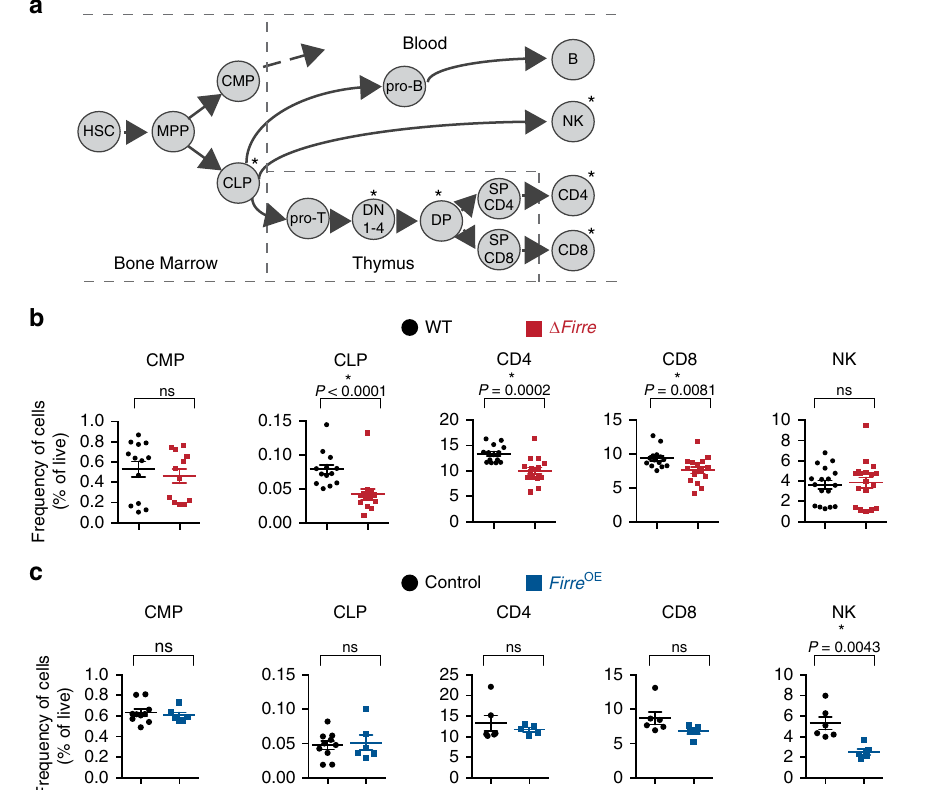
Fig. 3 Δ Firre and Firre OE mice have cell-speci fi c hematopoietic phenotypes. a Schematic of hematopoiesis. b Frequencies of common myeloid progenitors (CMP) and common lymphoid progenitors (CLP) in the bone marrow shown from WT ( n = 13, black circles) and Δ Firre ( n = 12-13, red squares) mice. Two representative experiments combined (three independent experiments). Frequencies of CD4 and CD8 cells from the peripheral blood from WT ( n = 14) and Δ Firre ( n = 15) mice. Frequency of NK cells from the peripheral blood from WT ( n = 17) and Δ Firre ( n = 18) mice. Three representative experiments combined (seven independent experiments). c Frequencies of CMPs and CLPs from the bone marrow from control (tg( Firre ) or WT or rtTA with dox) ( n = 10, black circle) and Firre OE + dox ( n = 6, blue square) mice. One representative experiment is shown (two independent experiments). Frequencies of CD4, CD8, and NK cells from the peripheral blood from control (WT or tg( Firre ) or rtTA with dox) ( n = 6, black circle) and Firre OE + dox ( n = 5, blue square) mice. One representative experiment is shown (three independent experiments). Cell frequencies determined by fl ow cytometry analysis. The data are plotted as percent (%) of live cells showing the mean ± SEM, and statistical signi fi cance determined by a two-tailed Mann – Whitney U test. Source data are provided in the Source Data fi